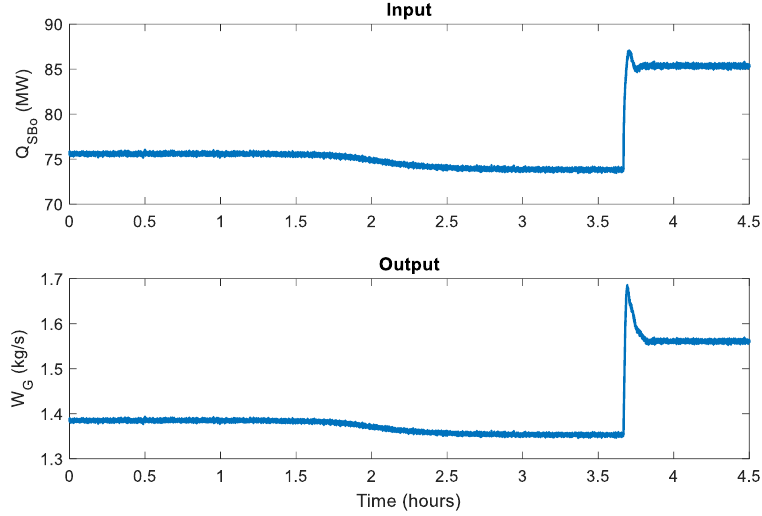
Figure 7. Dynamic response of W G for changes in Q SBo